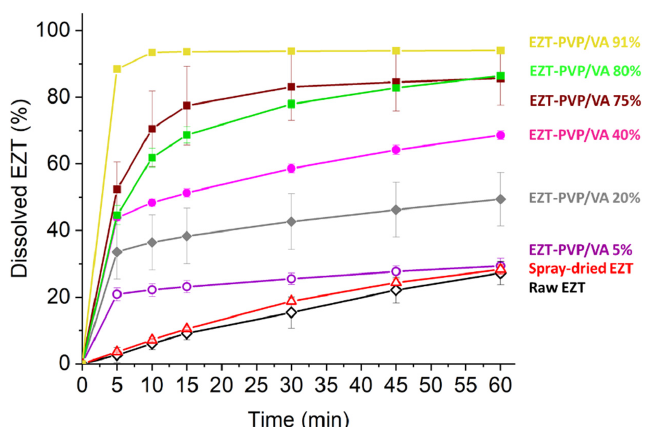
Figure 7. Dissolution profiles of selected EZT-PVP/VA solid dispersions, raw ezetimibe, and drug spray-dried without a carrier (content of polymer expressed as a wt%).